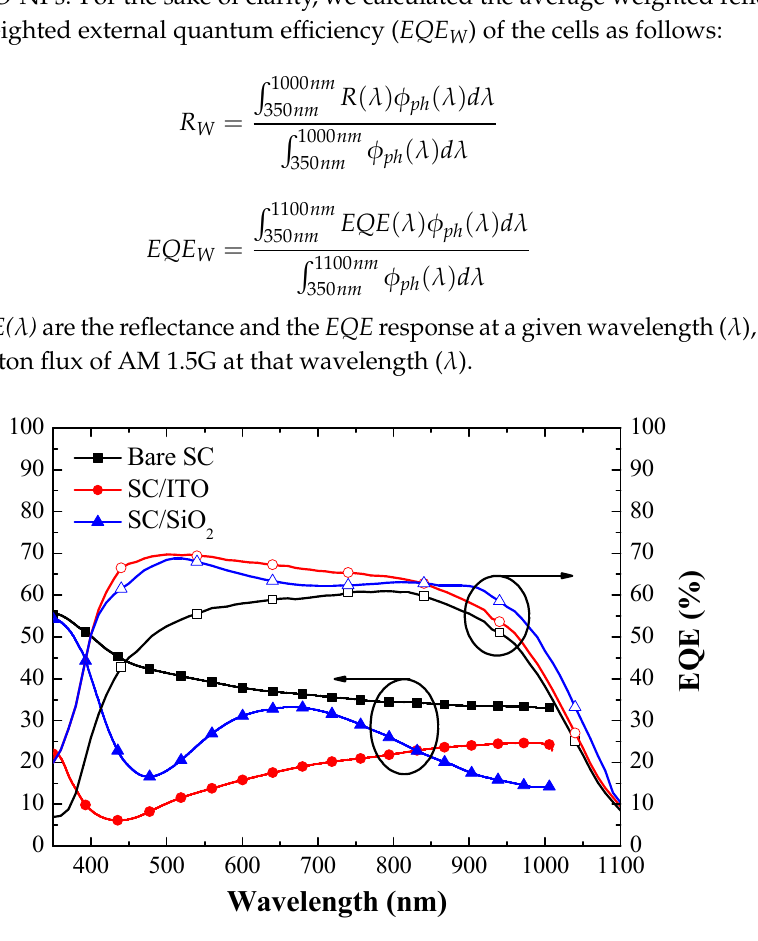
Figure 7. Optical reflectance spectra and external quantum efficiency (EQE) responses of the bare silicon solar cell, the solar cell with a SiO 2 layer, and the solar cell with an ITO layer. Table 2. Weighted reflectance ( R W ) and the weighted external quantum efficiency ( EQE W ) values of all fabricated cells.